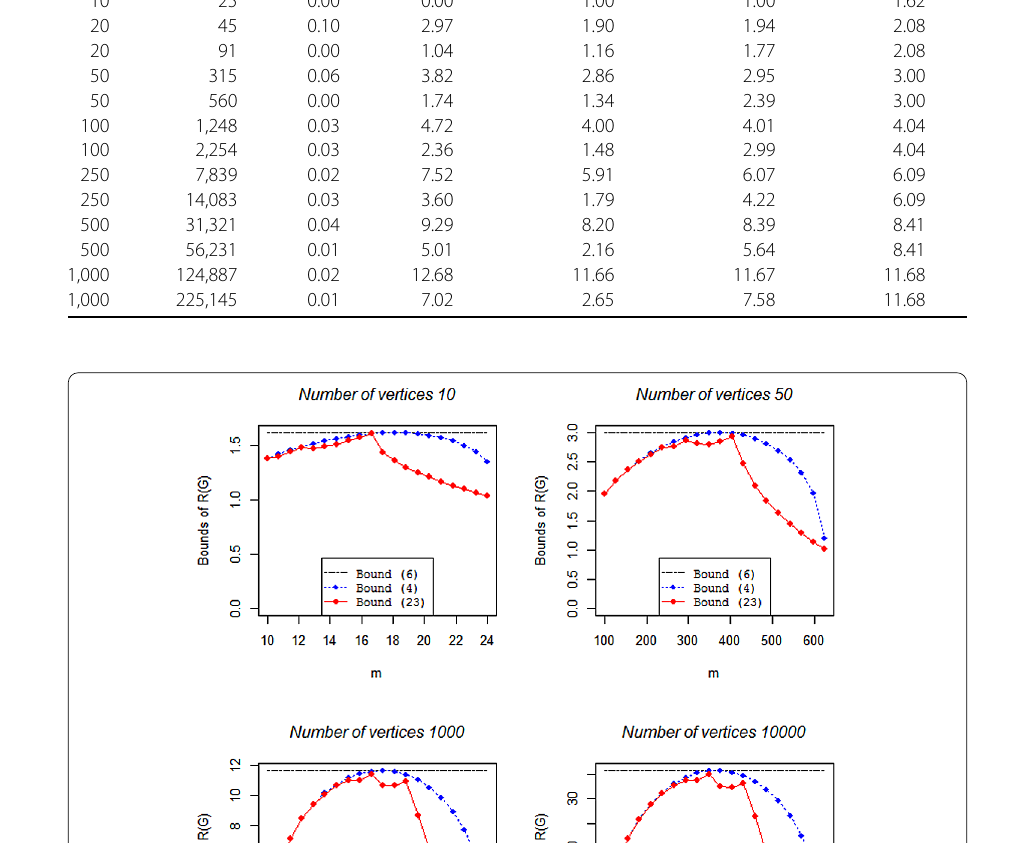
the interlacing between the eigenvalues of normalized Laplacian and adjacency matri- ces. On the other hand, new bounds are derived by making use of the relation between the HL -index and the energy index. Analytical and numerical results show the perfor- mance of these bounds on different classes of graphs. In particular, the bound related to the energy index performs better with respect to the best-known results in the liter-